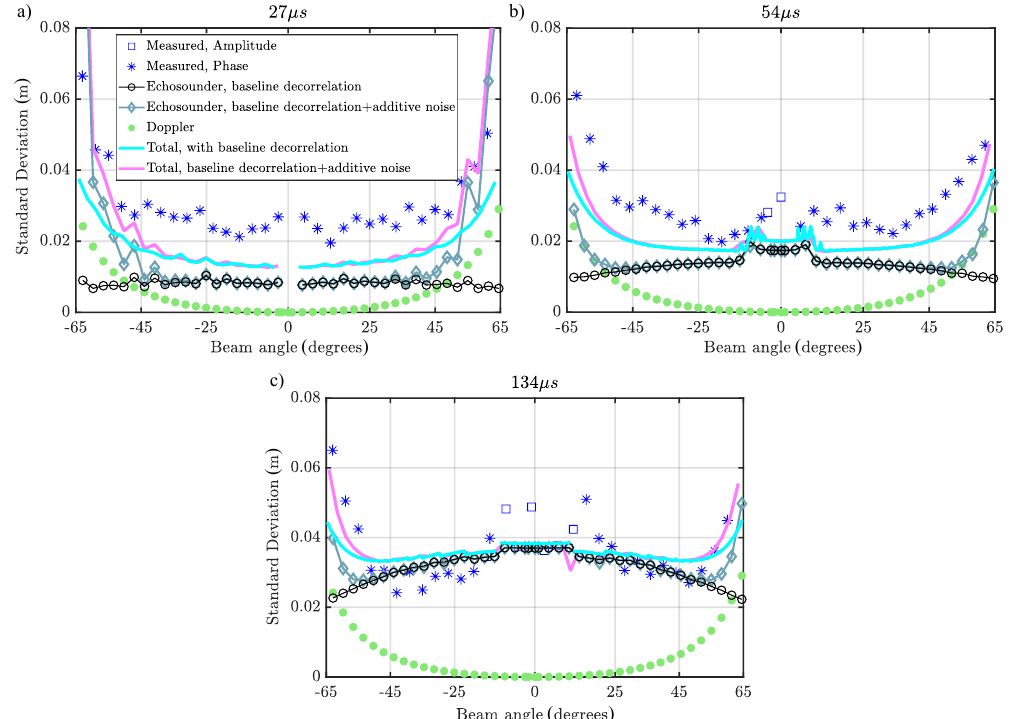
Figure 8. Bathymetric uncertainty derived from the measurements (blue) and those predicted considering the uncertainty induced by the Doppler effect and baseline decorrelation without (cyan) and with (light pink) additive noise for a water depth of 30m and a pulse length of ( a ) 27µs, ( b ) 54µs, and ( c ) 134µs. The change from amplitude to phase detection is shown by switching from square markers to asterisks with the same color. The location of this switch was similarly applied in the modeling. The depth uncertainty induced by motion sensor measurements, correction accuracy for misalignment, sound speed, and heave are equal to those of Figure 6 and are thus not shown